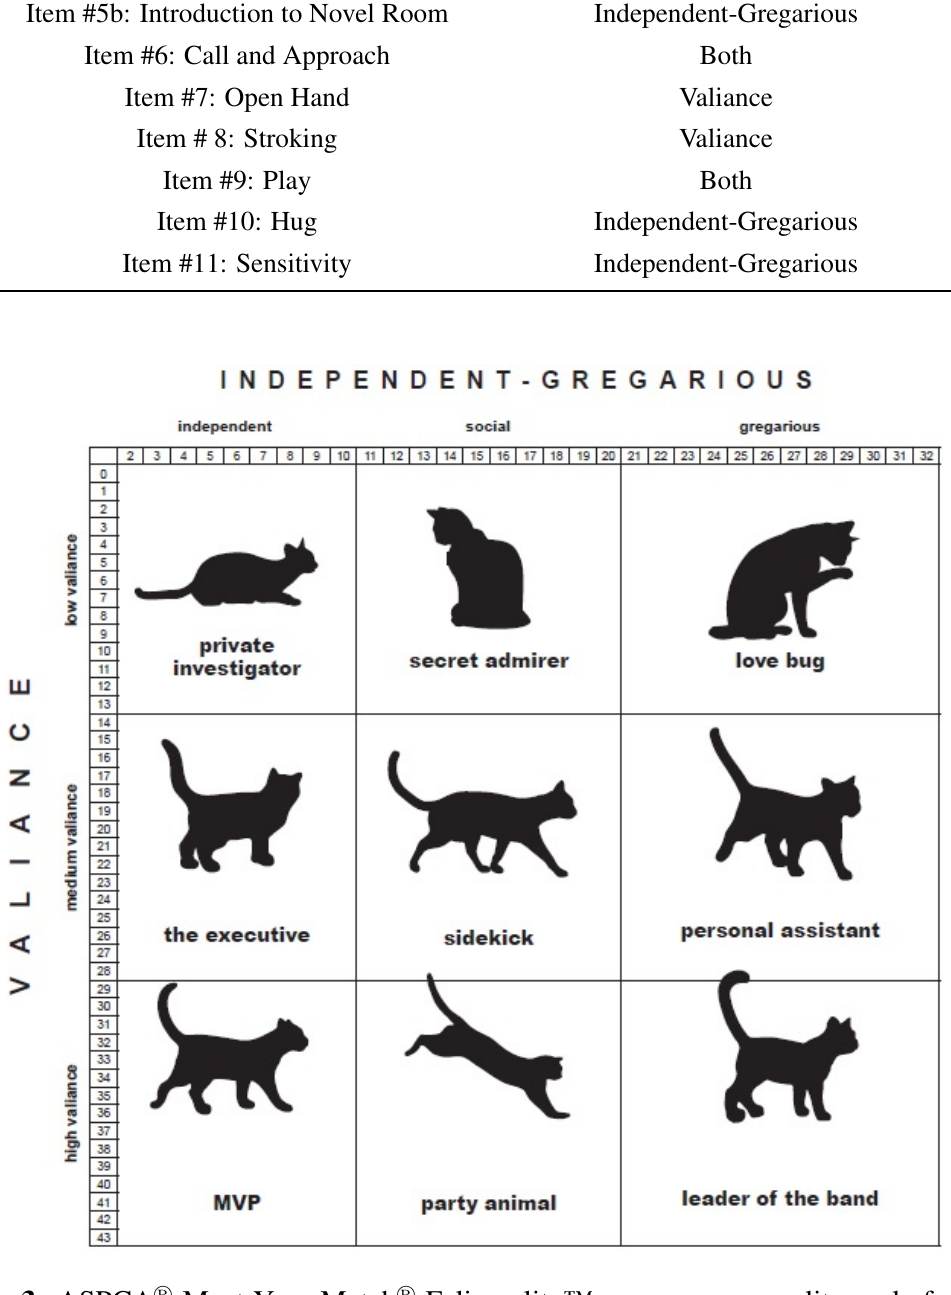
Figure 3. ASPCA (cid:114) Meet Your Match (cid:114) Feline-ality™ program personality scale from the Figure 3. ASPCA ® Meet Your Match ® Feline-ality™ program personality scale from the Modified Assessment Modified Assessment Group.